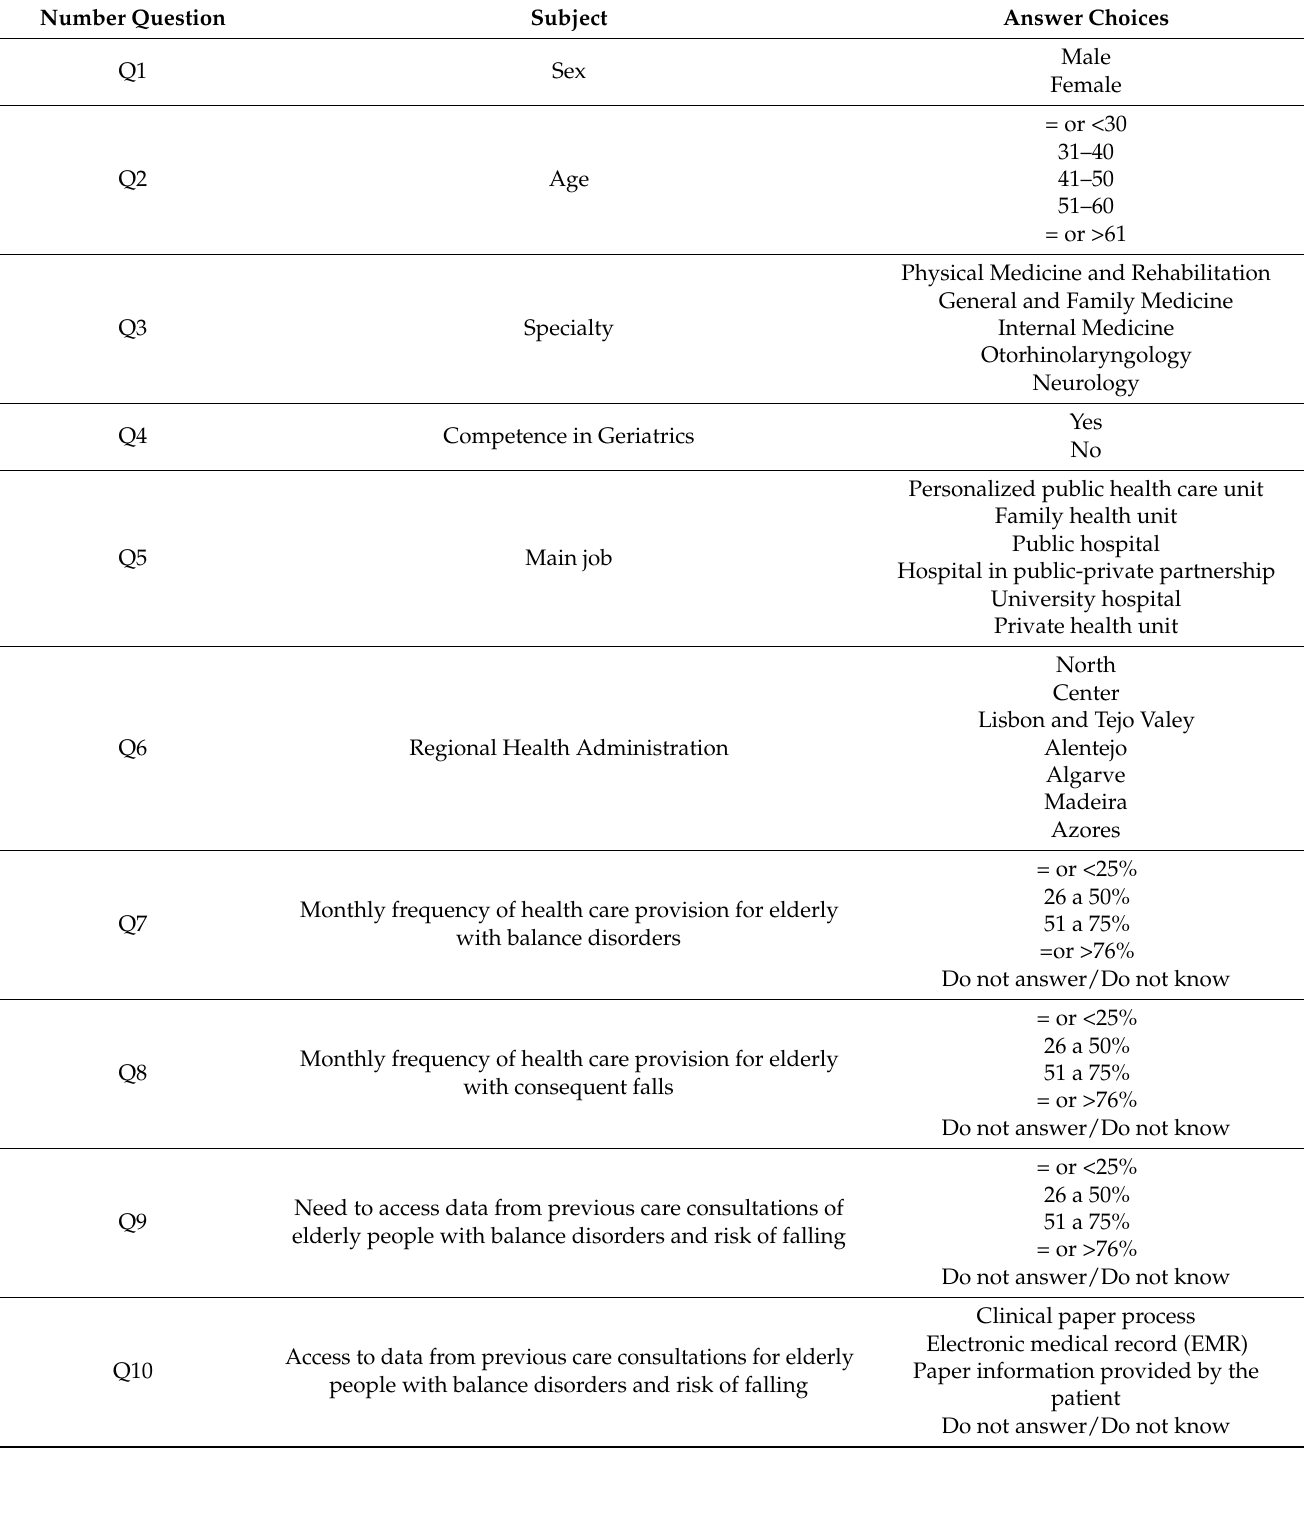
Table A1. Quantitative study: answer choices of the